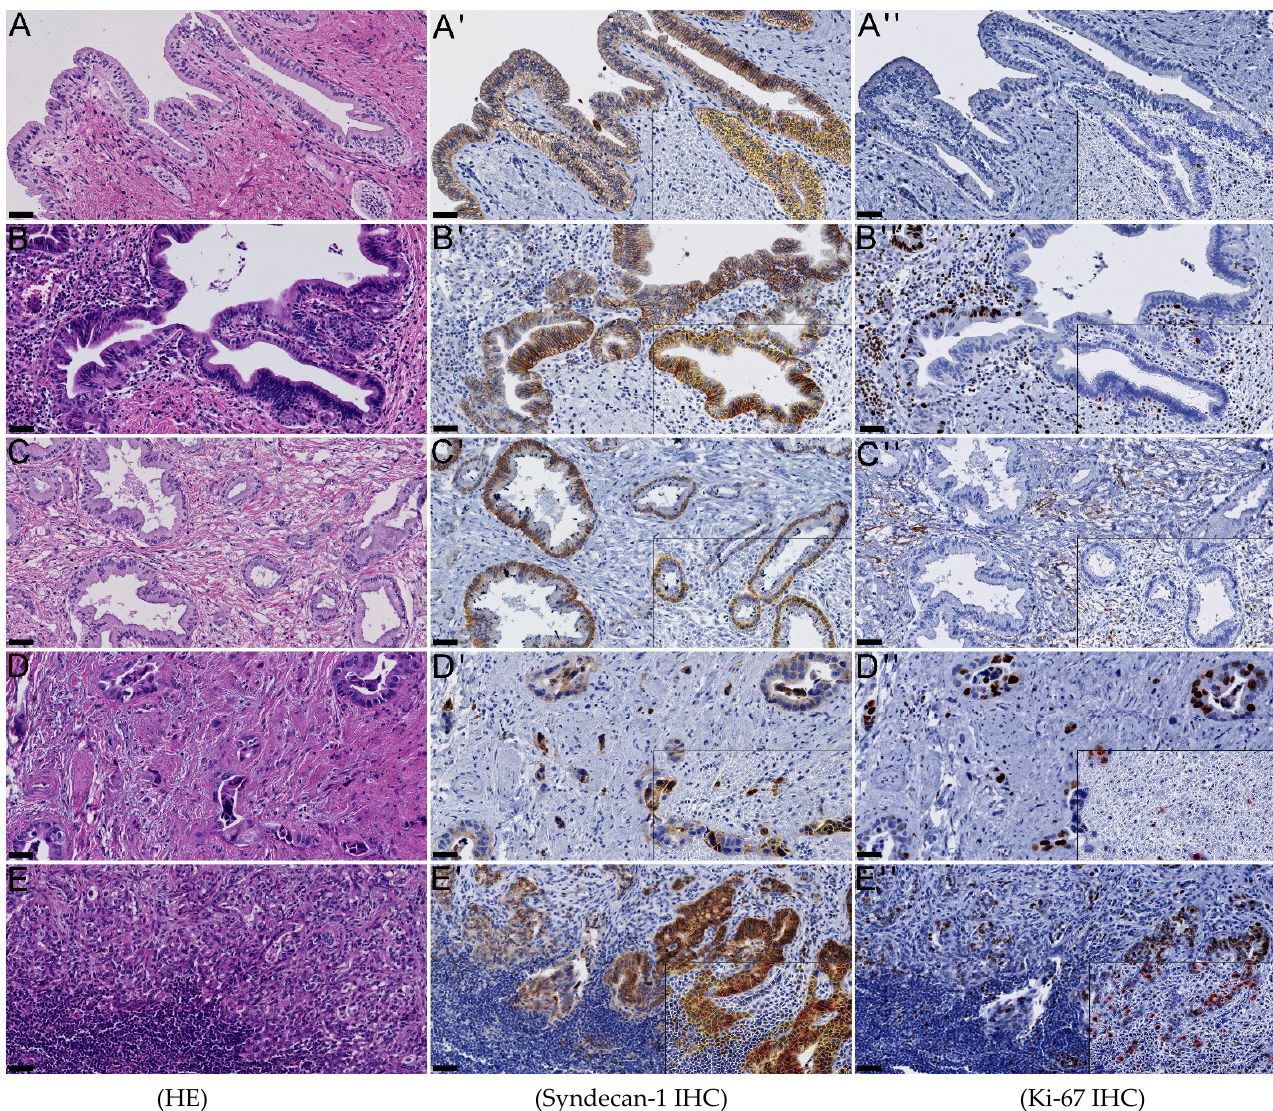
Figure 2. Syndecan-1 expression decreased in cholangiocarcinoma: In normal bile ducts ( A ), biliary intraepithelial neoplasia ( B ), and lymph node metastases ( E ), syndecan-1 staining was higher than in well- ( C ) and poorly differentiated ( D ) cholangiocarcinoma. ( A ) Perihilar bile duct, ( B ) low-grade BilIn, ( C – E ) PHCC. Syndecan-1 H-score: 79.81 ( A ), 81.22 ( B ), 45.20 ( C ), 34.70 ( D ), 106.31 ( E ). Ki-67: 0.06% ( A ), 9.07% ( B ), 0.98% ( C ), 41.67 ( D ), 32.51 ( E ). The overlay depicting QuPath- analysis is shown each on the bottom right ( A’ – E’ , A’’ – E’’ ). Classification of tumor staining intensity: red circumference 3+, orange 2+, yellow 1+, blue 0; stroma in white ( A’ – E’ ); red circumference positive, blue negative; stroma in white ( A’’ – E’’ ). Black bars: each 50 µm.